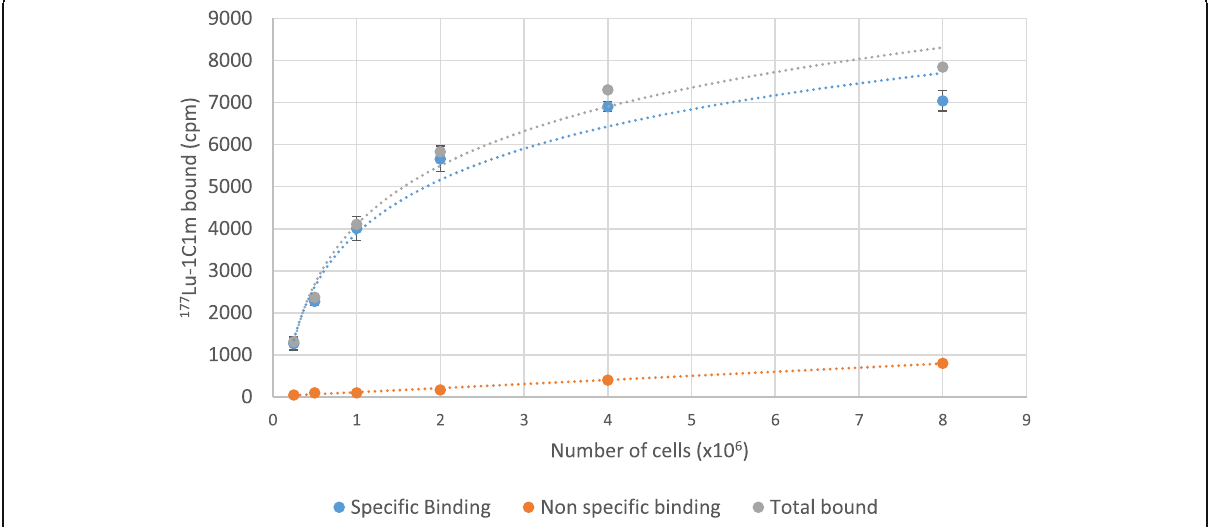
Fig. 5 [177Lu]Lu-1C1m-Fc immunoreactivity test on SK-N-AS cell line, binding curve, B max = 8490 cpm, total activity = 9460